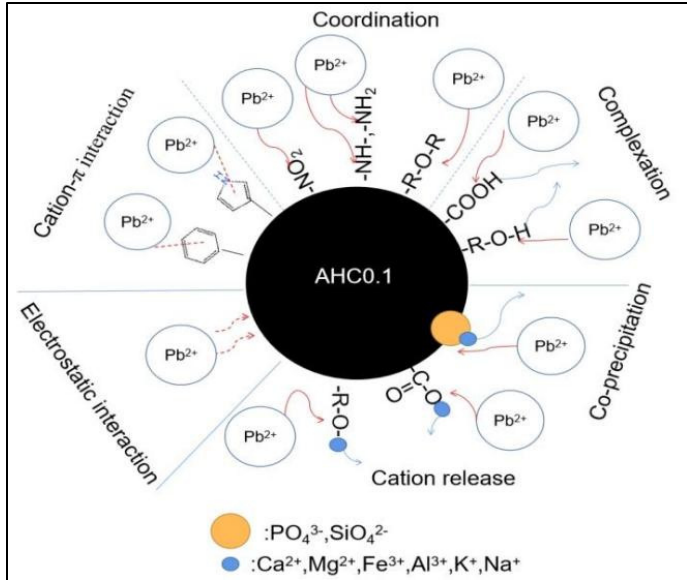
Figure 13. Schematic of Pb( Ⅱ ) adsorption mechanism by AHC0.1.